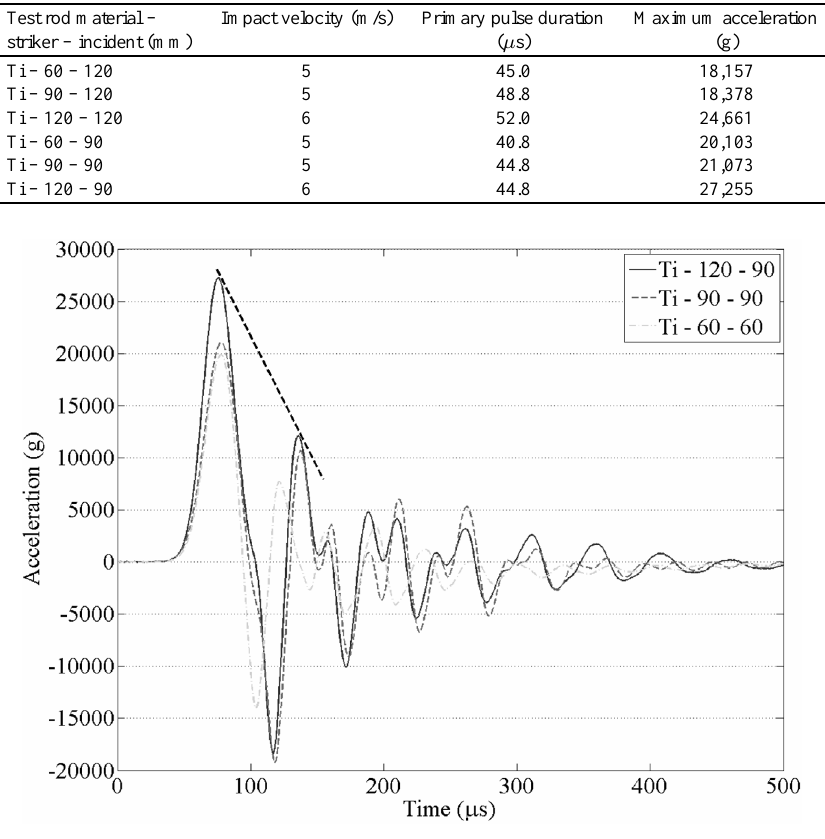
Fig. 4. Comparison of acceleration traces for the 120, 90 and 60 mm long striker bars and the 60 and 90 mm long titanium test rods. durations recorded for longer striker bars. The acceleration signals are therefore a close approximation to the ideal case of a uni-modal shock pulse leading to a single pulse loading for an attached micro-device. A sample of the range of acceleration data for the Inconel HPB testing is tabulated in Table